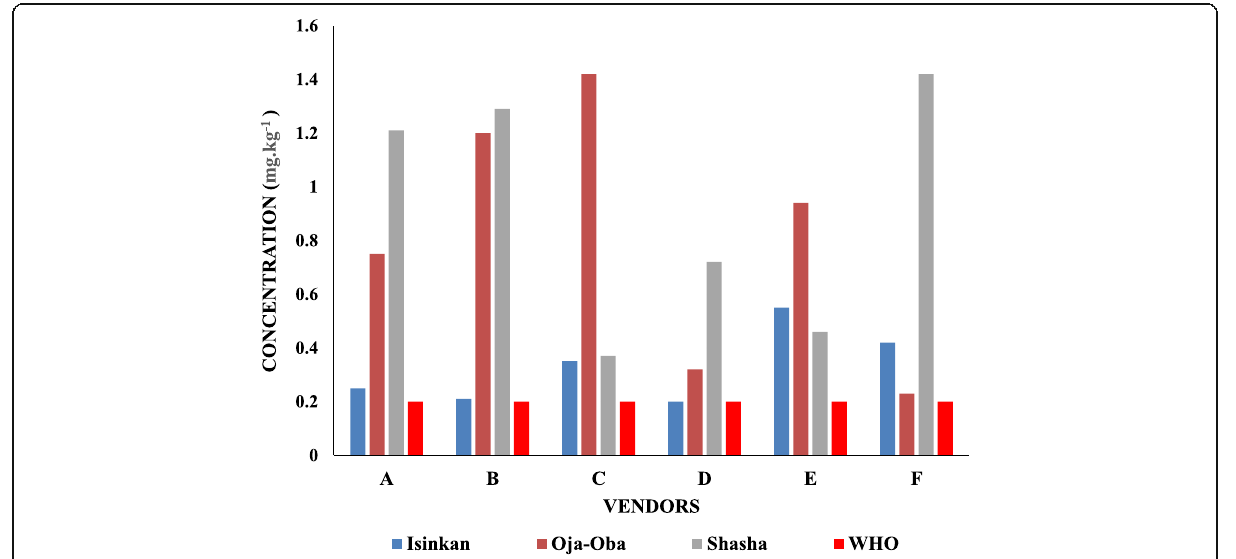
Fig. 3 Comparison of nickel concentrations in the sliced watermelon fruits with WHO permissible level